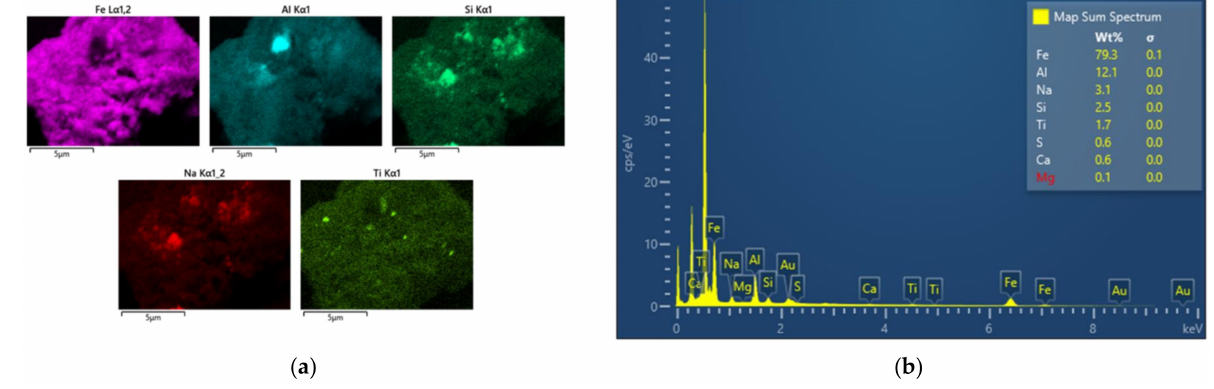
Figure 4. ( a ) X-ray mapping of the ALUM BR (10 kV, 20 Kx). ( b ) EDX Spectrum of ALUM BR.